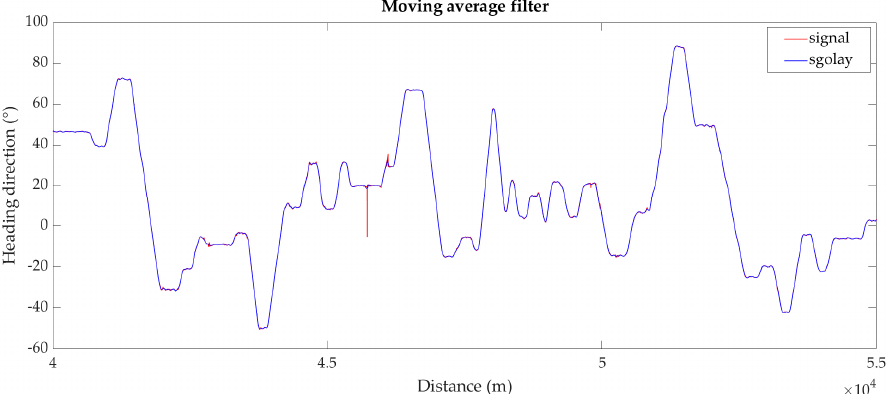
Figure 8. Heading direction graph, compared to moving average filter ‘sgolayfilt’ type of the HWY 4—from the distance 40 km to the distance 55 km.